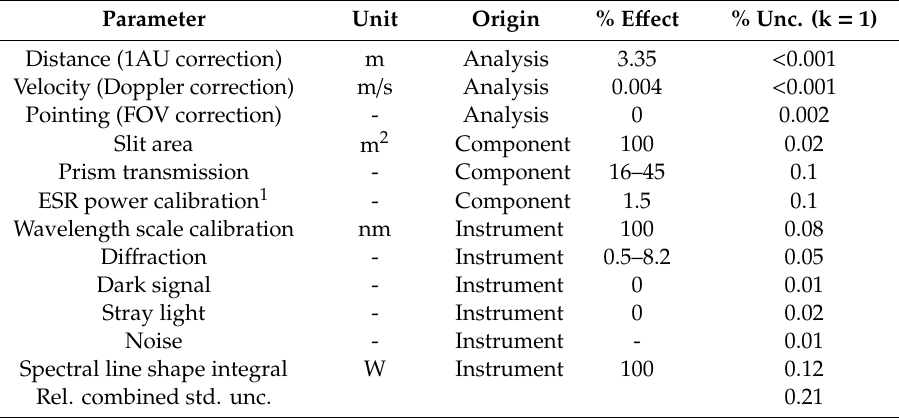
Table 7. TSIS-1 SIM uncertainty budgets and